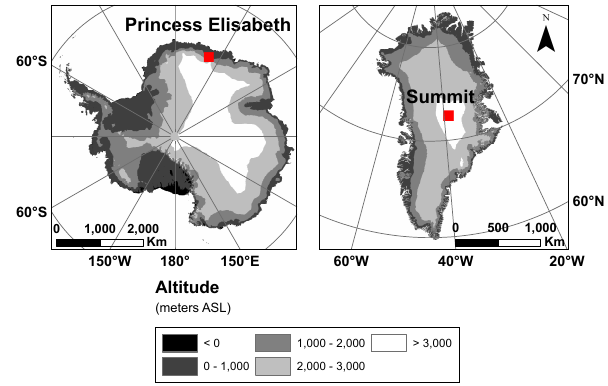
Fig. 2. Locations of PE (Antarctica) and Summit (Greenland) re- search